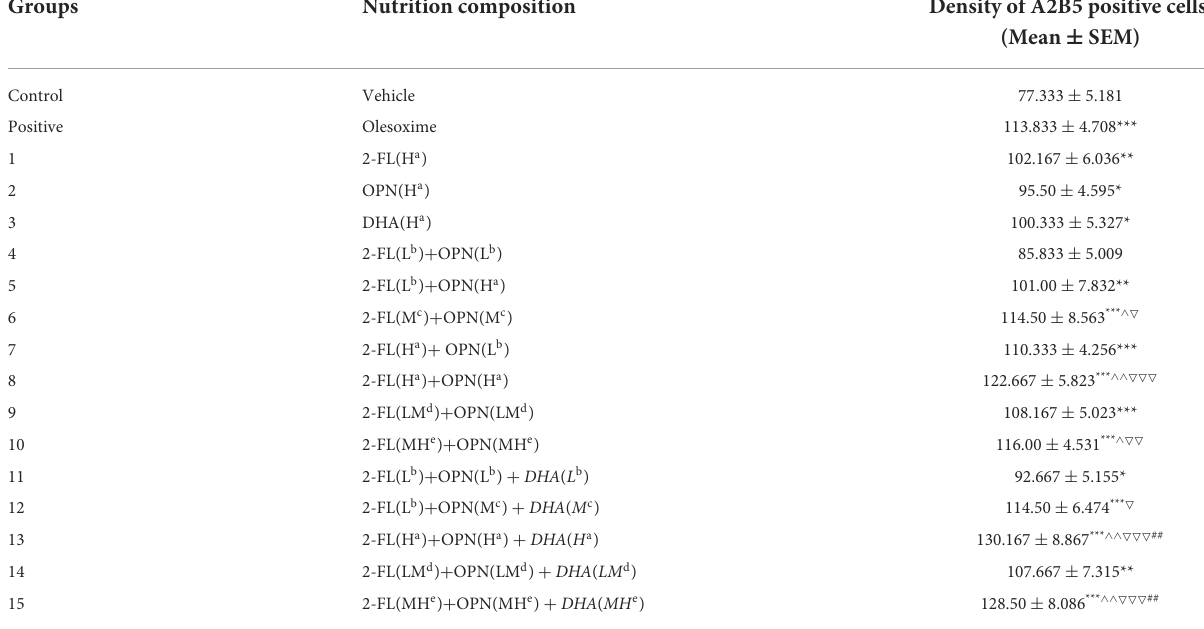
TABLE 2 Effects of different nutritional compositions containing 2’-FL, OPN and/or DHA on the number of A2B5 positive